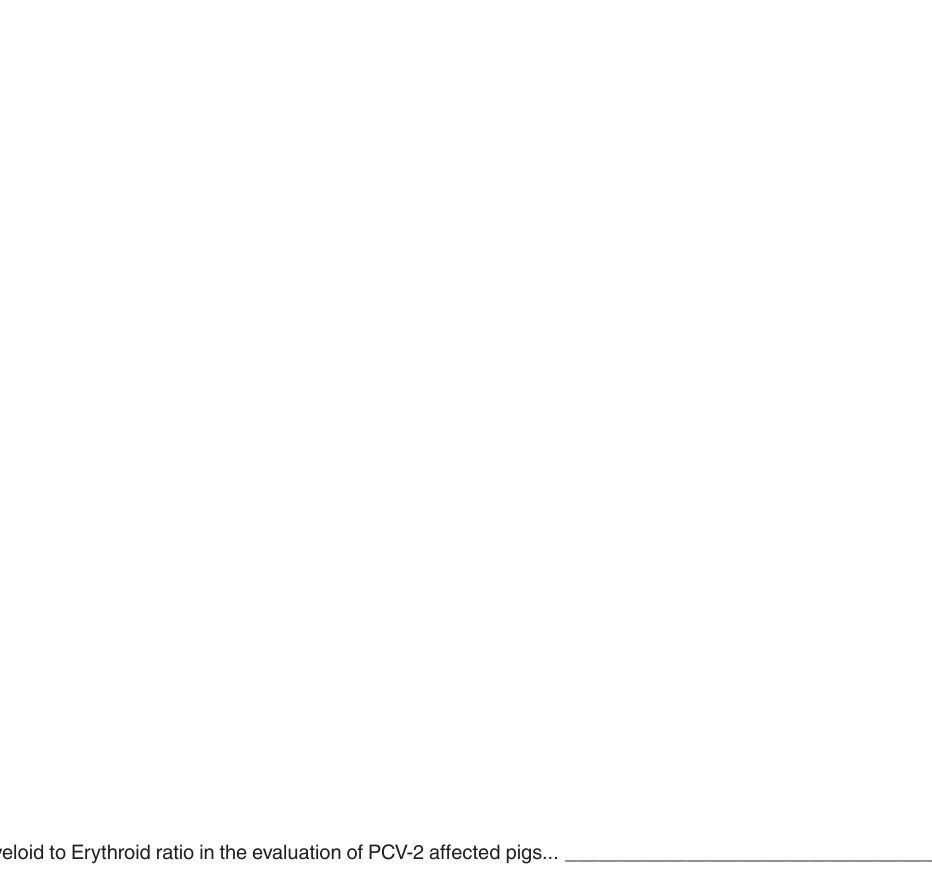
256 Myeloid to Erythroid ratio in the evaluation of PCV-2 affected pigs...